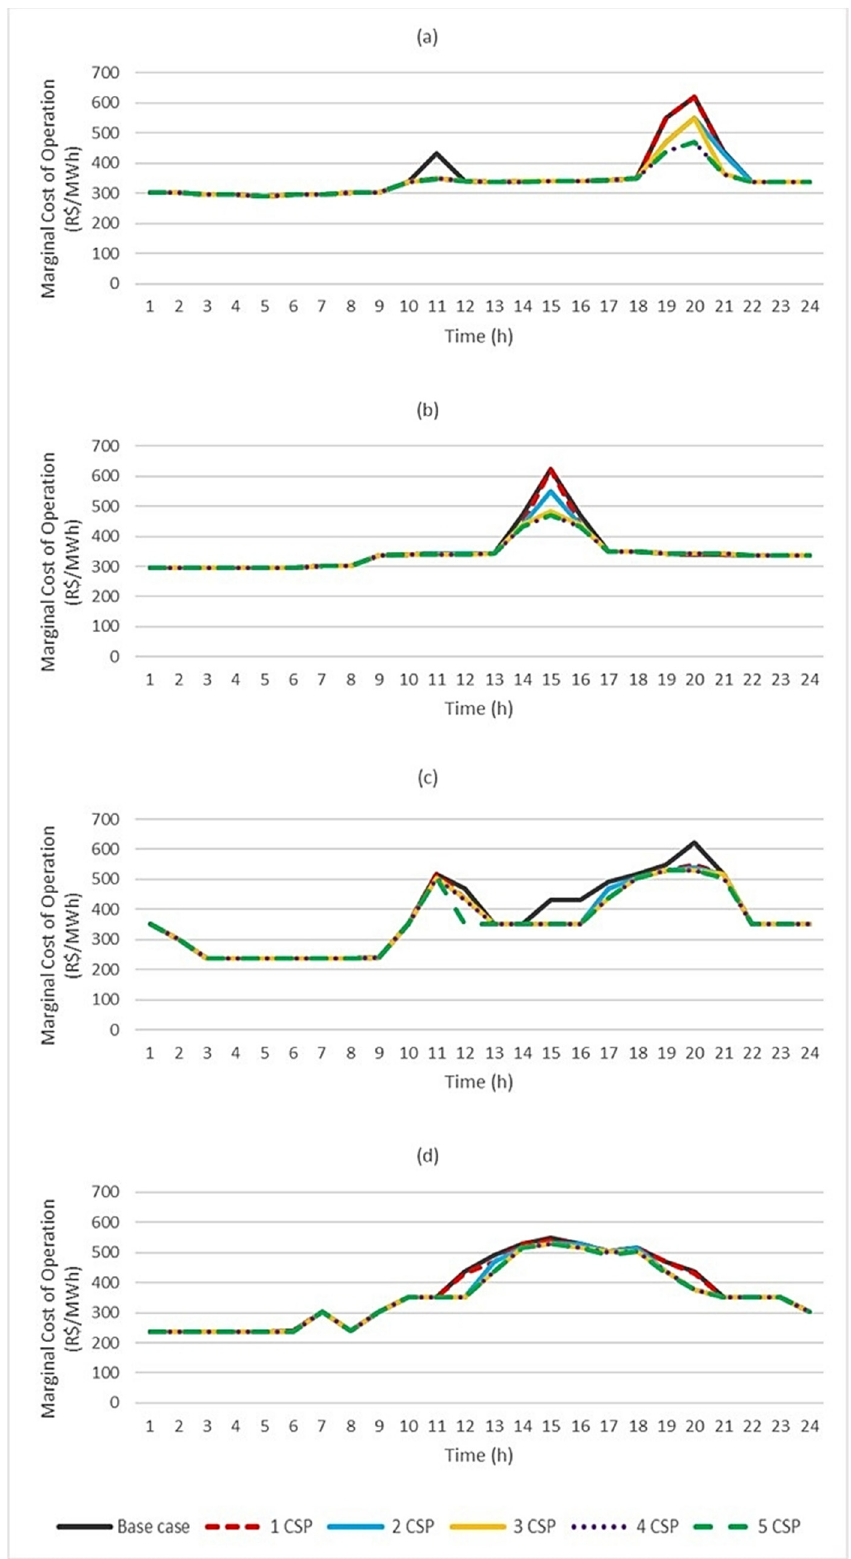
Figure 8. Marginal operating cost of the hydrothermal system in the following scenarios: wet/night ( a ), wet/day ( b ), dry/night ( c ), and dry/day ( d ).